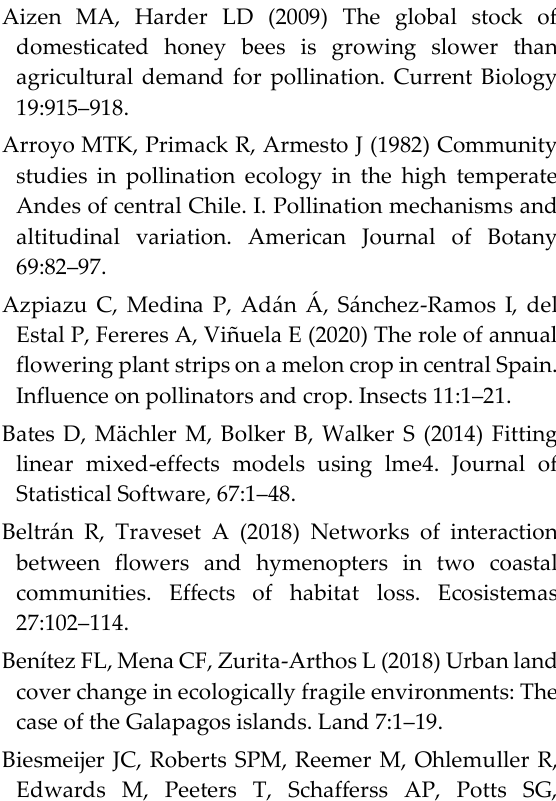
Table S1. Pollinator species list registered in the censuses from 2008 to 2011 in